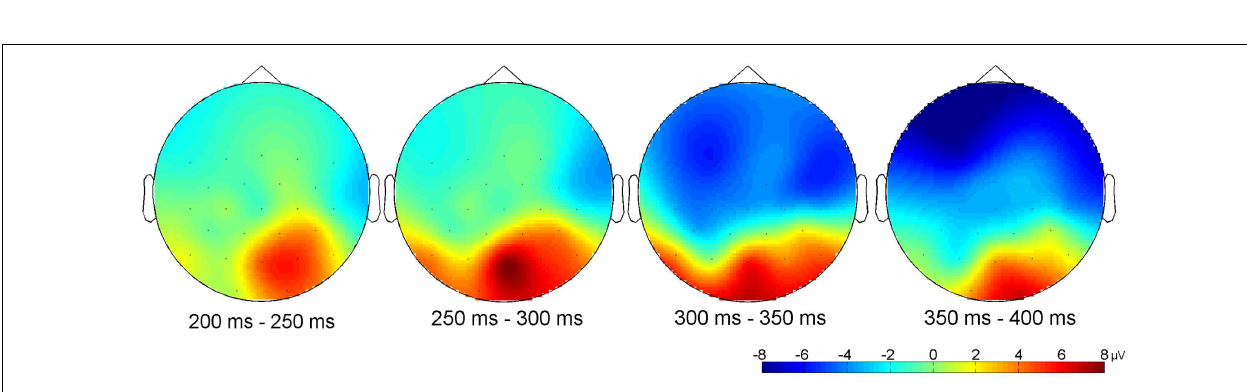
FIGURE 5 | ERPs elicited by synchronous (black line) and asynchronous (gray lines) stimuli in the first 1000ms of stimulus presentation ( n = 15). Note that the auditory event occurred at 474ms in both experimental conditions (indicated by solid vertical lines).